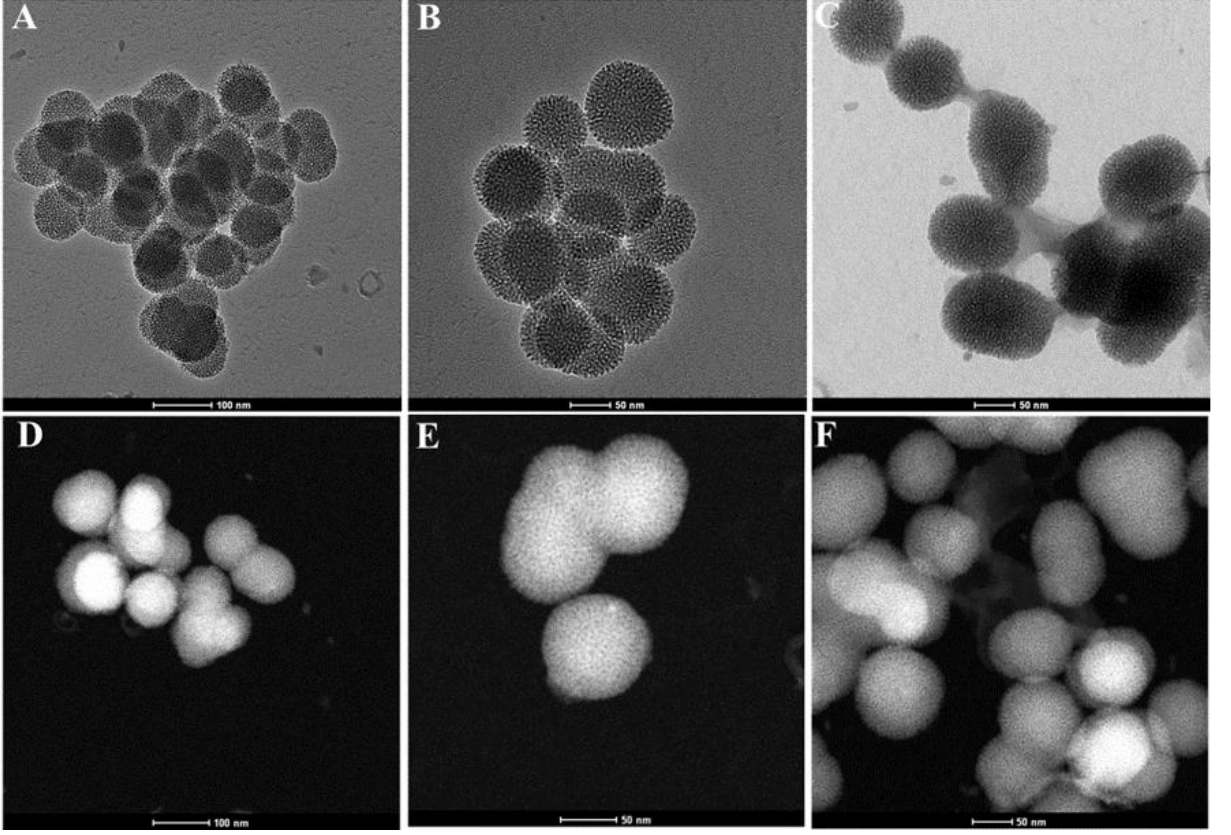
Figure 1. STEM images for nanoformulations before and after polymeric-FA coating showing the morphological changes. ( A ) TEM image: MSN. ( B ). TEM image: MSNPCLCR. ( C ) TEM image: MSNPCLCR/CSCEFA. ( D ) STEM image: MSN. ( E ) MSNPCLCR. ( F ) MSNPCLCR/CSCEFA.